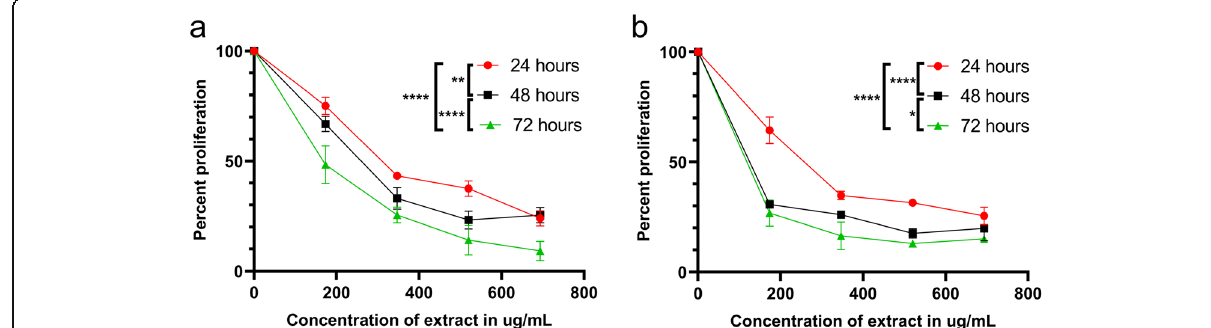
Fig. 1 The effect of AELE on cell proliferation using MTS assay. Proliferation of Monomac-1( a ) and KG-1 ( b ) cells after 24, 48, and 72 h of treatment with increasing concentrations of AELE. The absorbance was measured at 492 nm. A significant dose and time-dependent decrease in proliferation of AML cells was observed upon increasing concentrations of AELE. The IC50 s were reached at 333.4 μ g/mL for Monomac-1 and 254.5 μ g/mL for KG-1 at 24 h. A time-dependent decrease in the IC 50 s was observed for both cell lines at 48 and 72 h. (* indicates a p -value: